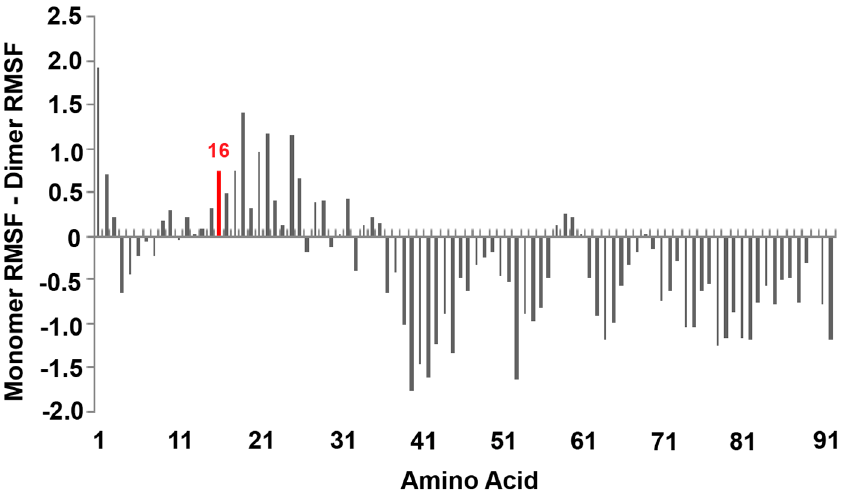
Figure 9. Amino acid movement (root mean squared fluctuation, RMSF) during MD simulations for the NMR generated model (monomer) relative to the modeled metalated dimer structure following 10 nanoseconds of MD. Data is shown as the movement of the monomer minus the dimer; amino acids with positive values have higher movement in the monomer while negative values have higher movement in the dimer.